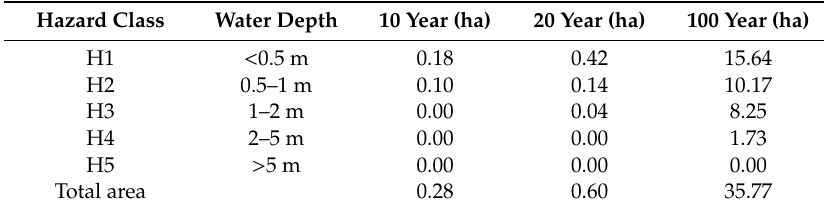
Table 7. Areas a ff ected by the floods of di ff erent return periods for the settlement Volgodonovka (Classification 1).